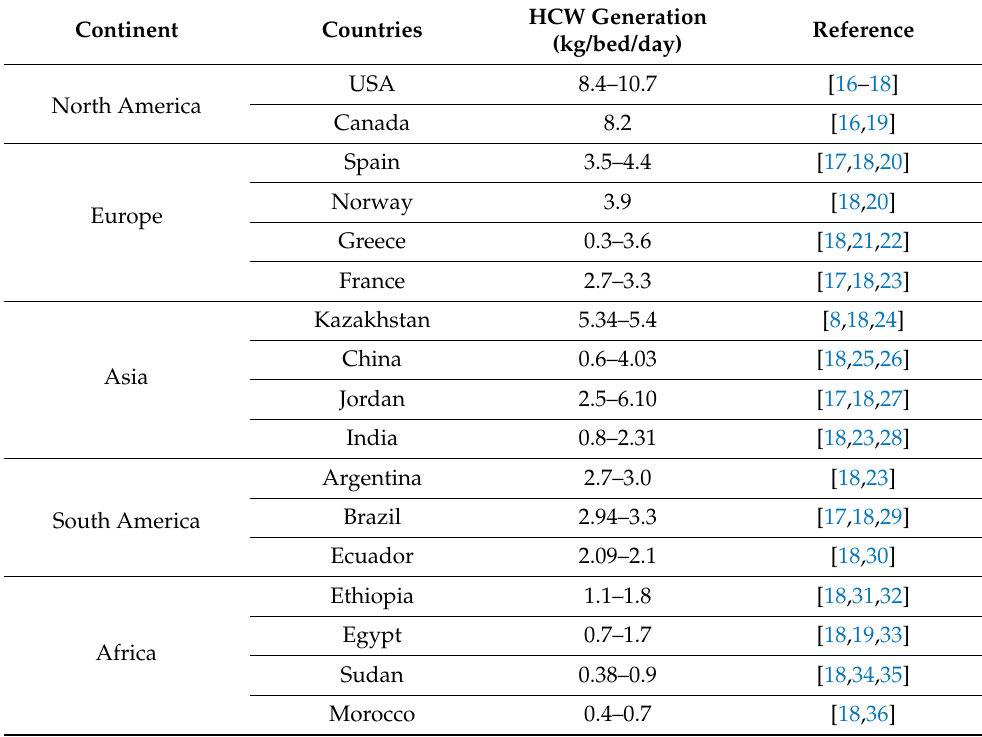
Table 3. Example of HCW production rate in various countries